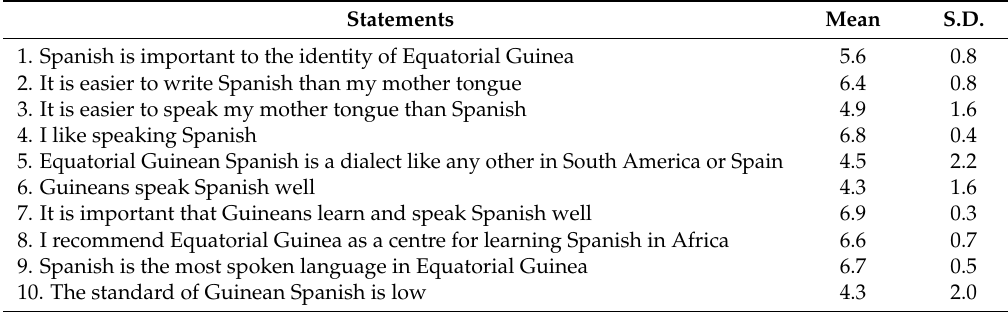
Table 3. Opinions about Spanish.